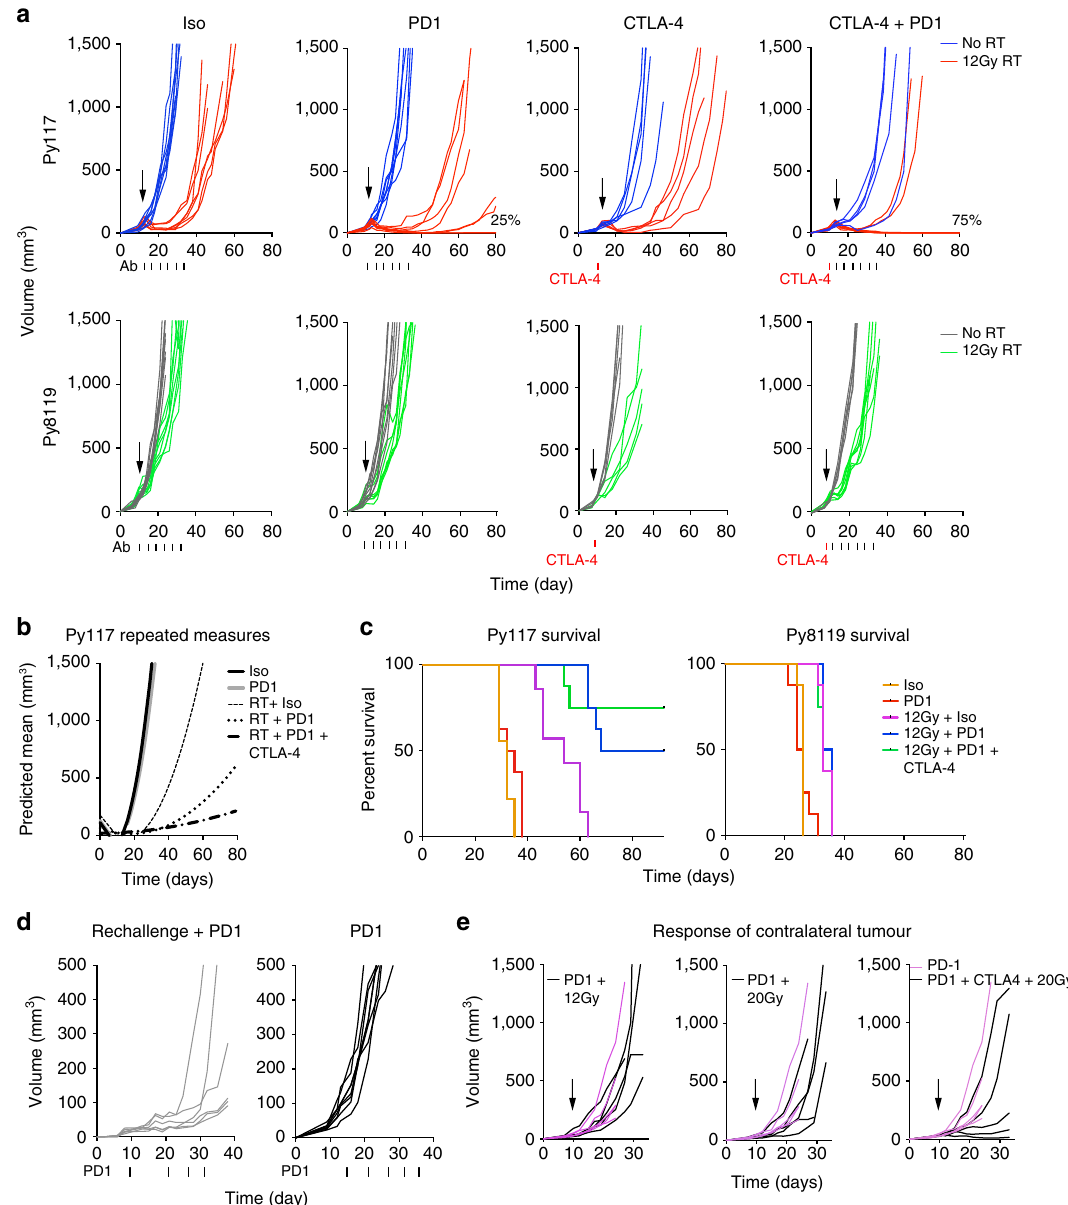
Figure 3 | RT and immunotherapy leads to cures in the responsive Py117 tumours. ( a ) Tumour growth curves treated with and without 12Gy RT plus isotype control Ab, PD-1 Ab, a single dose of CTLA-4 Ab 3 days before 12Gy, or CTLA-4 and PD-1 Ab combination revealed cures with RTand PD-1 Ab in Py117 tumours but no response in Py8119 cells (% ¼ per cent of eight mice with complete response, n ¼ 5–8). ( b ) The modelled Py117 tumour curves were significantly different between 12Gy and 12Gy þ PD-1 or 12Gy þ PD-1 þ CTLA-4 ( P ¼ 0.002 and 0.0004, respectively). ( c ) There was a difference in survival of Py117 but not Py8119 tumour bearing mice with radiation and PD-1 combinations ( P o 0.0001, log rank test). ( d ) Contralateral fat pad rechallenge in mice treated with 12Gy þ PD-1 þ CTLA-4 and PD-1 ab resulted in greater latency compared with PD-1 Ab alone. ( e ) Tumours were implanted in both inguinal fat pads and one tumour was radiated with 12Gy or 20Gy 10 days after implantation and combination of PD-1 or PD-1 þ a single dose of CTLA-4 antibody revealing a response in the contralateral tumour in three of the five mice treated with 20Gy þ PD-1 þ CTLA-4 (five mice per group, purple curves ¼ mice treated with PD-1 Ab